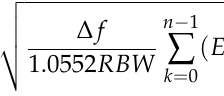
Table 1. Maximum deviations of E-field strength averaged over 1 min from that averaged over 6 min. Frequency Range [MHz] 700 1500 2100 Maximum deviation [dB] 0.5 0.6